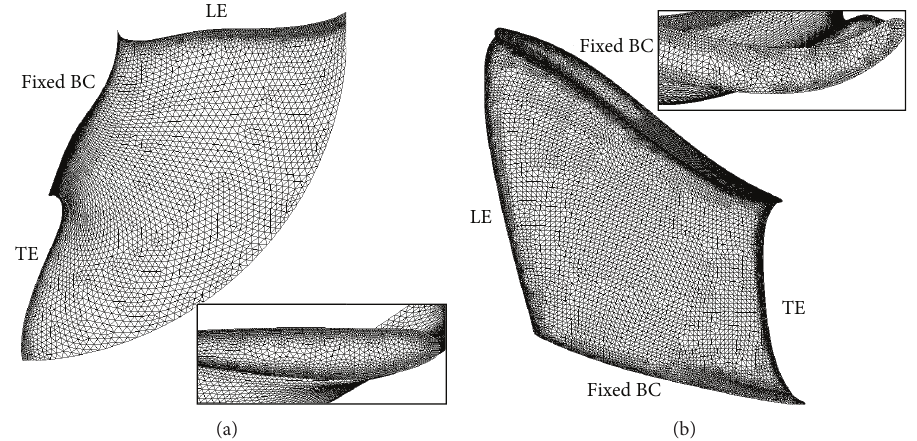
Figure 20: Discretized FEM mesh for the rotor (a) and stator (b) blades.